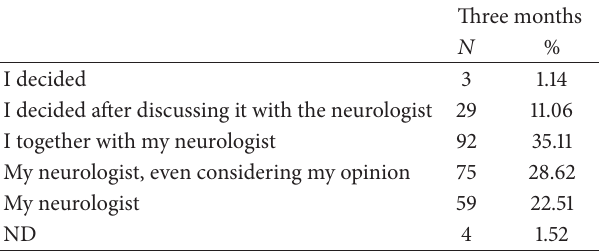
Table 4: “Who decided to start therapy?”